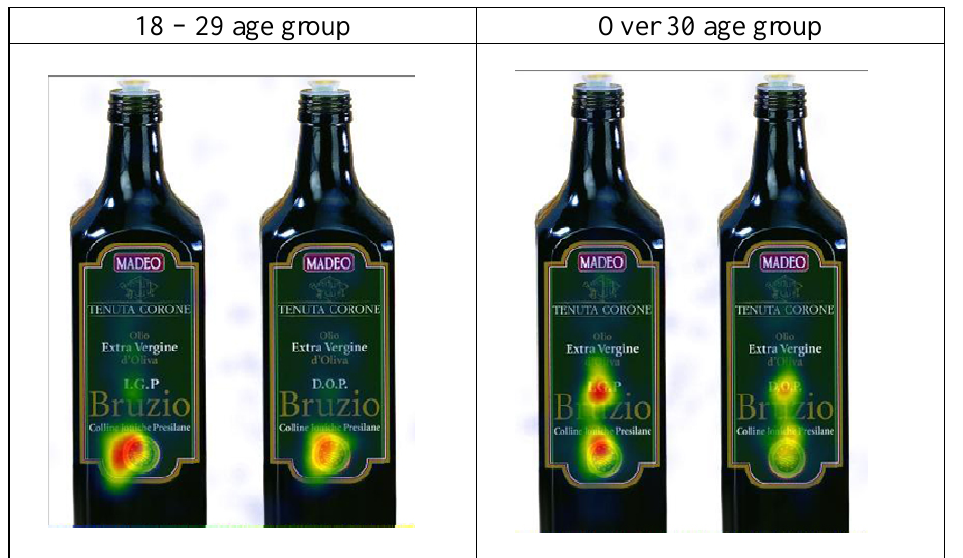
Figure 1: Heatmaps with the Average Gaze for the 18-29 Age Group and Over 30 Age Group 18 – 29 age group Over 30 age